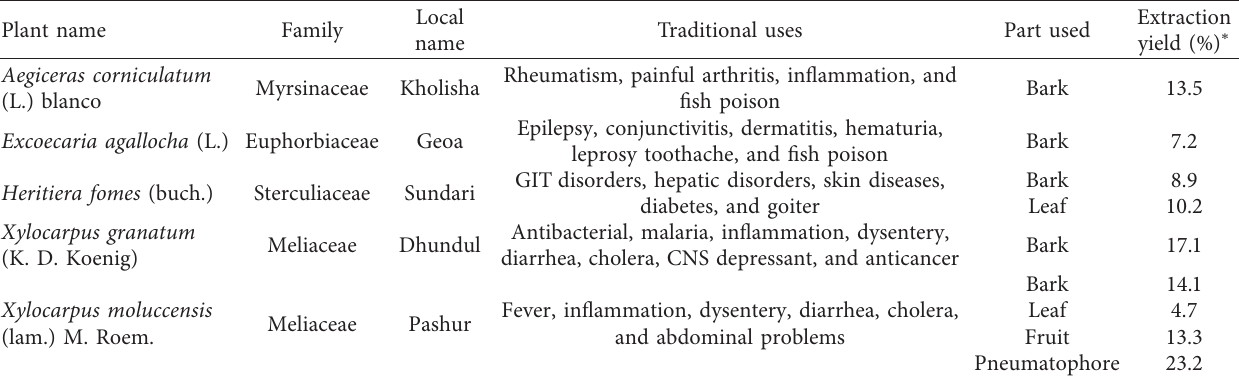
Table 1: List of collected Sundarban plant species for methanol extraction, their traditional uses, part used, and extraction yields [24]]. Plant